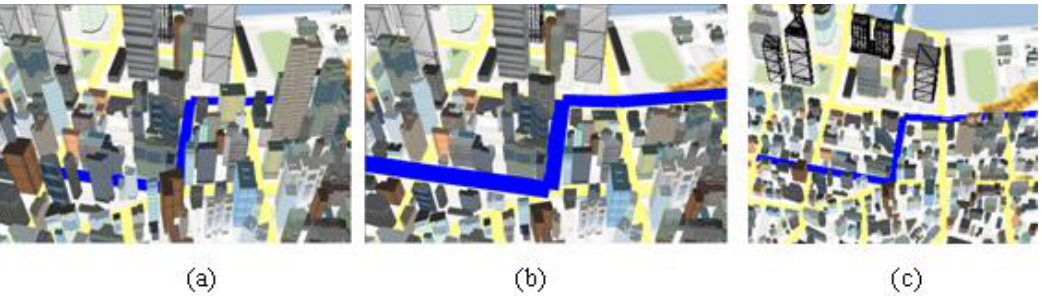
Figure 8. A z-shaped road in Hong Kong: ( a ) original perspective view; ( b ) occlusion-free view; and ( c ) the original perspective view from a very high camera height.